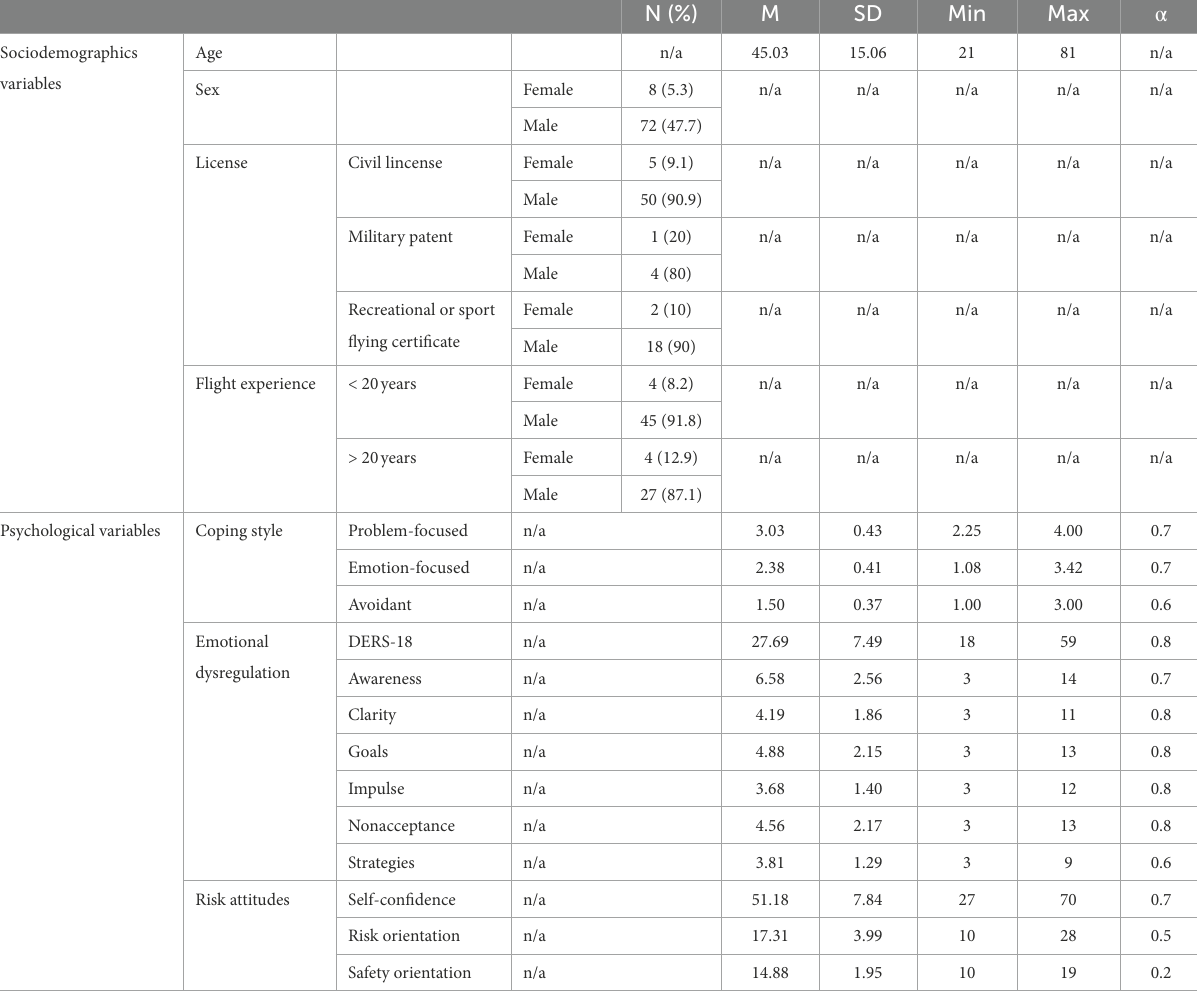
TABLE 1 Descriptive statistics of sociodemographics variables, coping style, emotional dysregulation, and risk